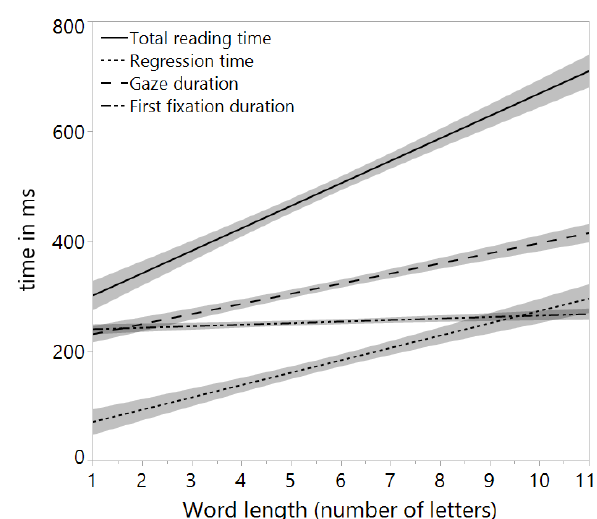
Figure 2. Word Length comparisons (words from 1 to 11 letters) for first fixation duration, gaze duration, total reading time, and rereading time in ms. The shaded area represents 1 SE from the mean. Extreme values were excluded (0.5% of the